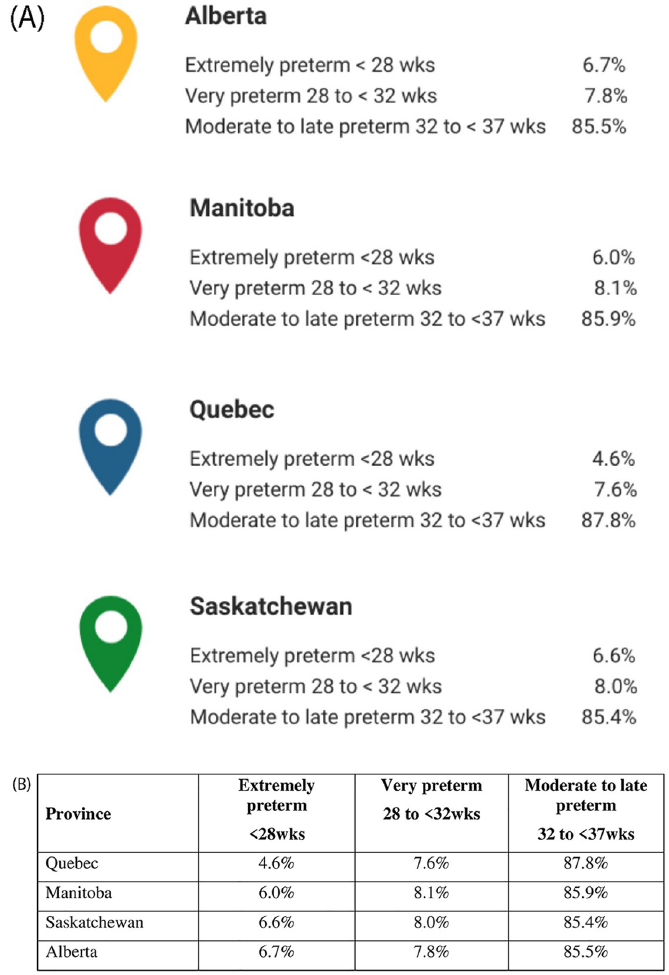
Fig 2. CAMCCO—Quebec, Manitoba, Saskatchewan, and Alberta—Overall prevalence of categories of prematurity. Note: Data on preterm births were missing from SK’s birth abstracts for the years 1996–2000.